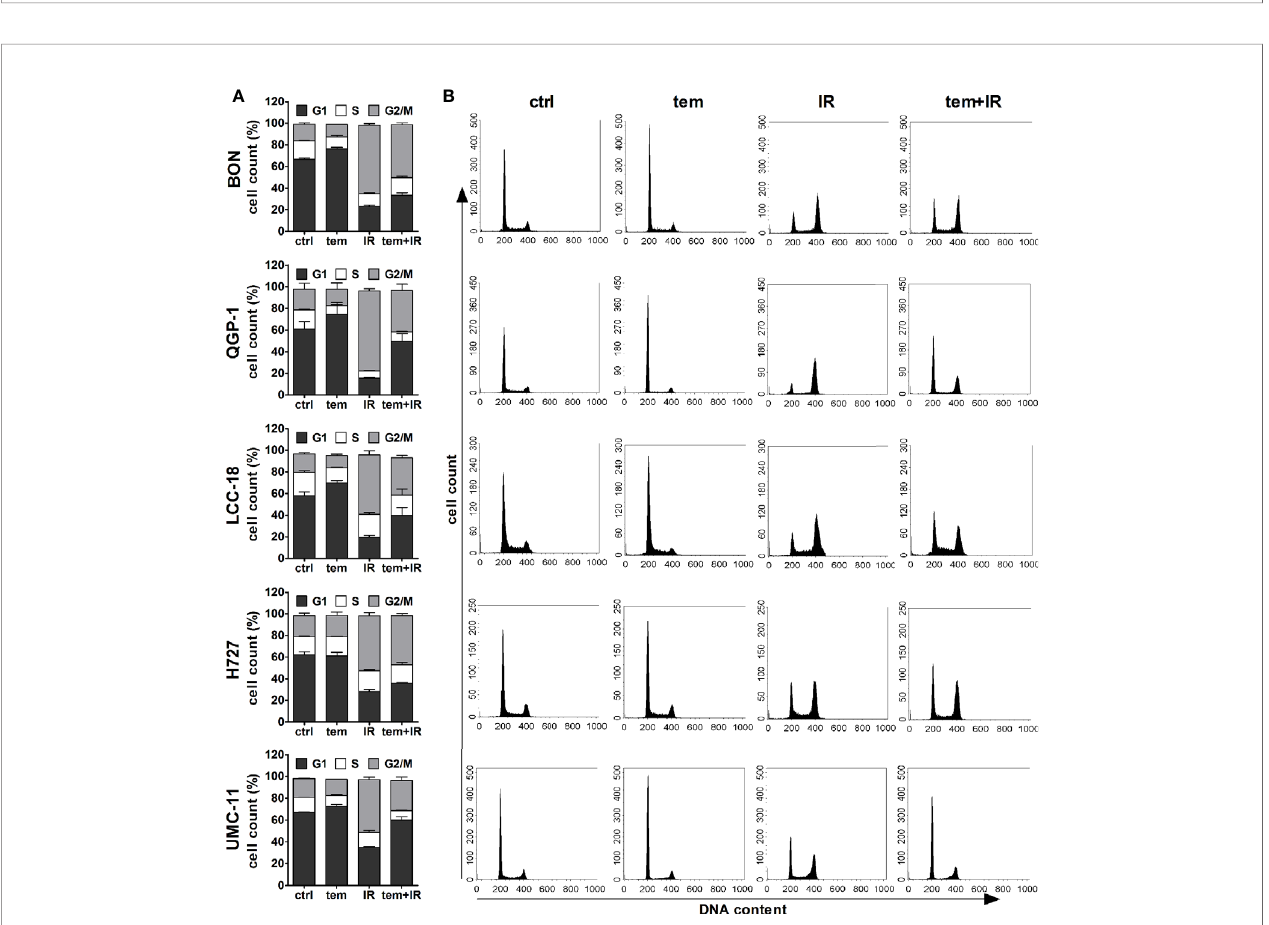
FIGURE 10 | Temsirolimus pretreatment abrogates radiation-induced G2/M cell accumulation. NEN cell lines were incubated with 1 µM temsirolimus (tem) or vehicle (ctrl) for 24 h before irradiation. For assessment of cell cycle distribution pretreated NEN cells were collected 24 h after irradiation with 10 Gy (IR, tem+IR), stained with propidium iodide and analyzed by fl ow cytometer. Data are shown as bar diagrams with mean ± S.E.M. (n=2 – 3) (A) or as DNA histograms of one representative experiment (B)